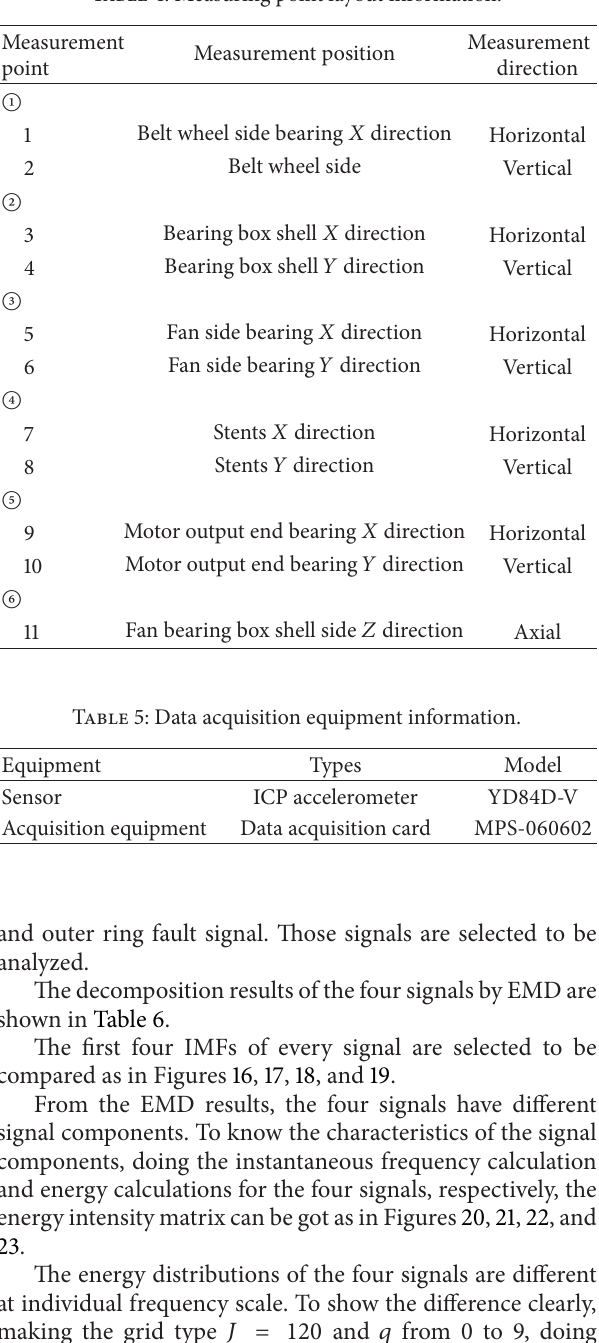
Table 3: The bearing information of the equipment. Table 4: Measuring point layout information.